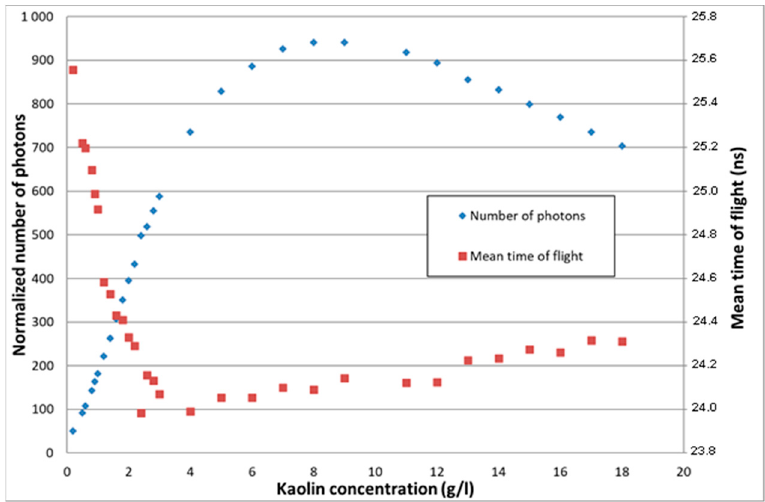
Figure 10. Combined evolution of the normalized number of photons and mean time of flight as a function of the particle concentration.